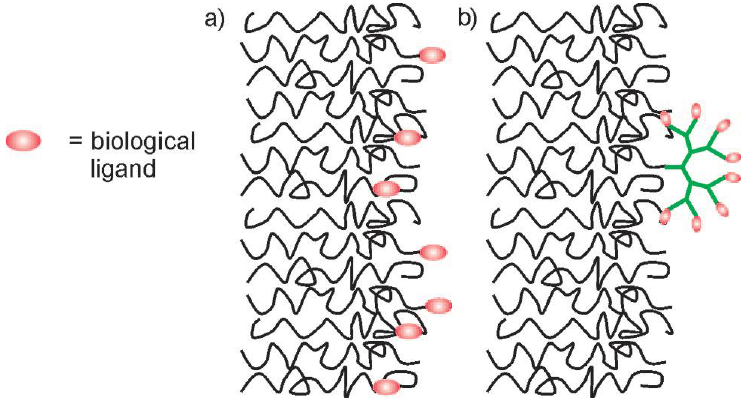
Figure 5 . Schematic illustration of preformed polymersome membranes functionalized with ( a ) nondendritic and ( b ) dendritic biological ligand displays. Reproduced by permission of the American Chemical Society